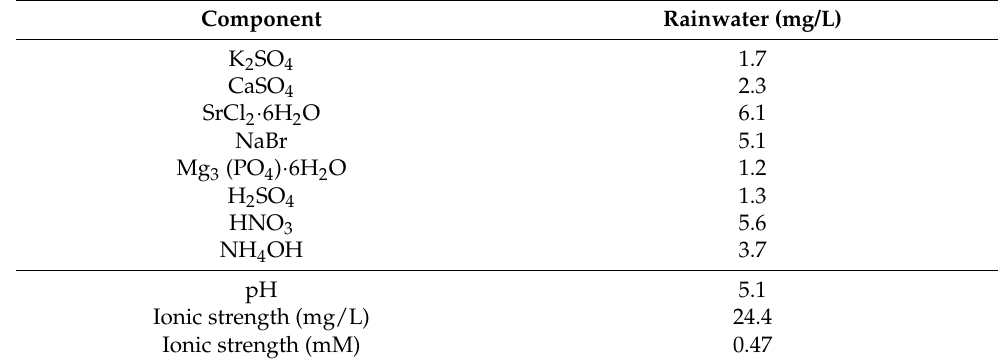
Table 1. Synthetic rainwater composition used in the study, adapted from